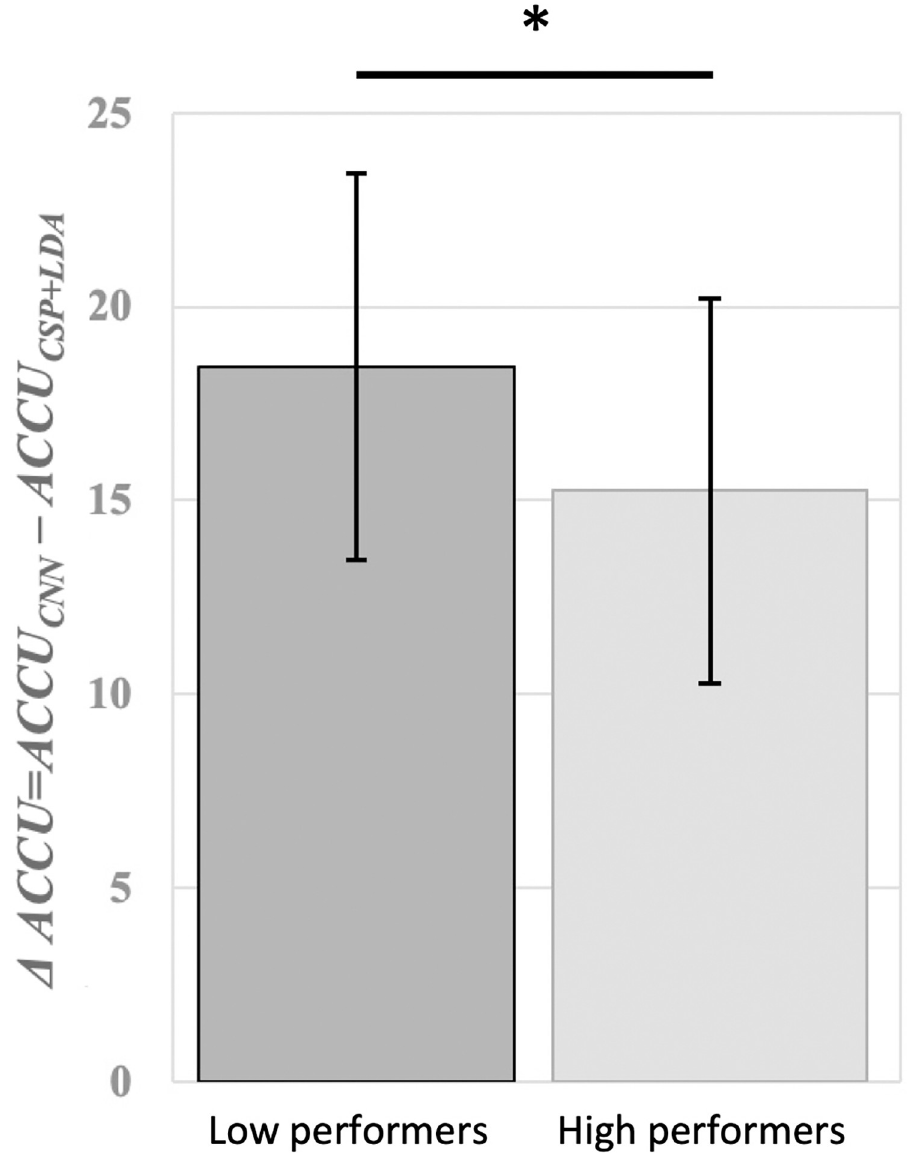
Fig 4. Mean difference between accuracies of CNN and CSP+LDA models ( Accu CNN −Accu CSP+LDA ) for Low Performer and High Performer groups. Low Performers showed significantly higher improvement in MI-BCI accuracy after using a CNN